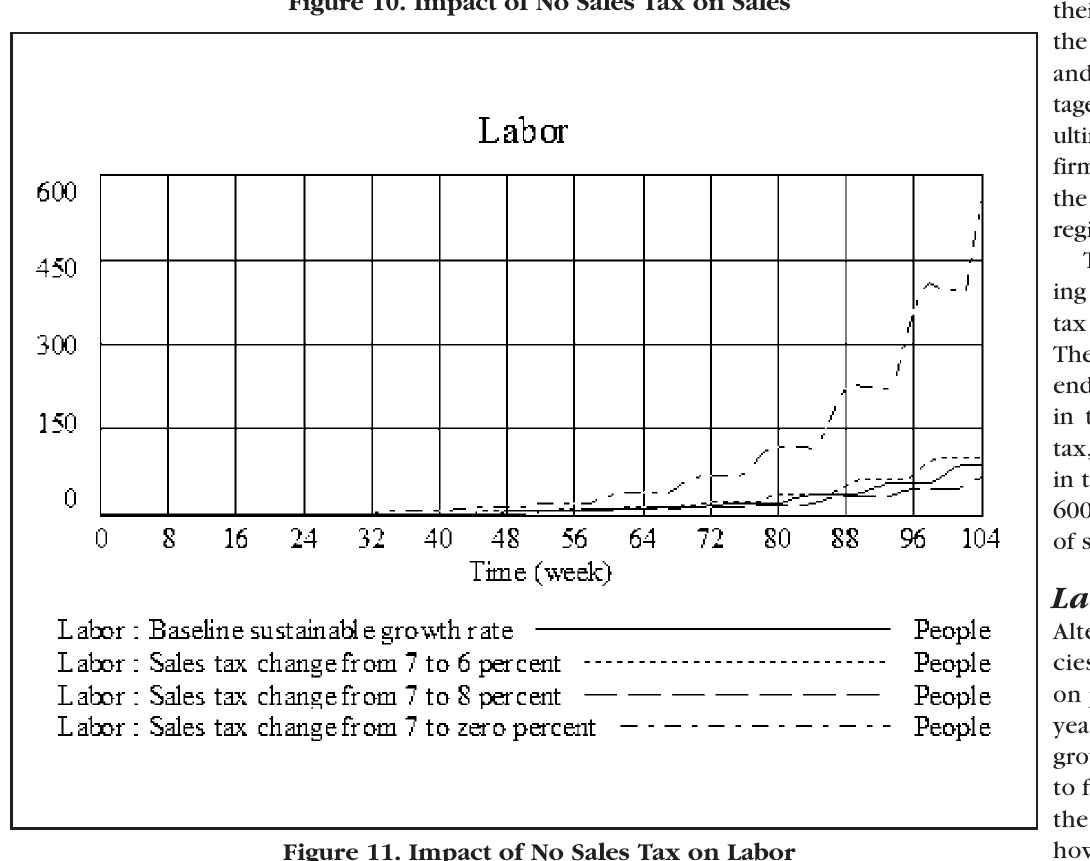
Figure 10. Impact of No Sales Tax on Sales